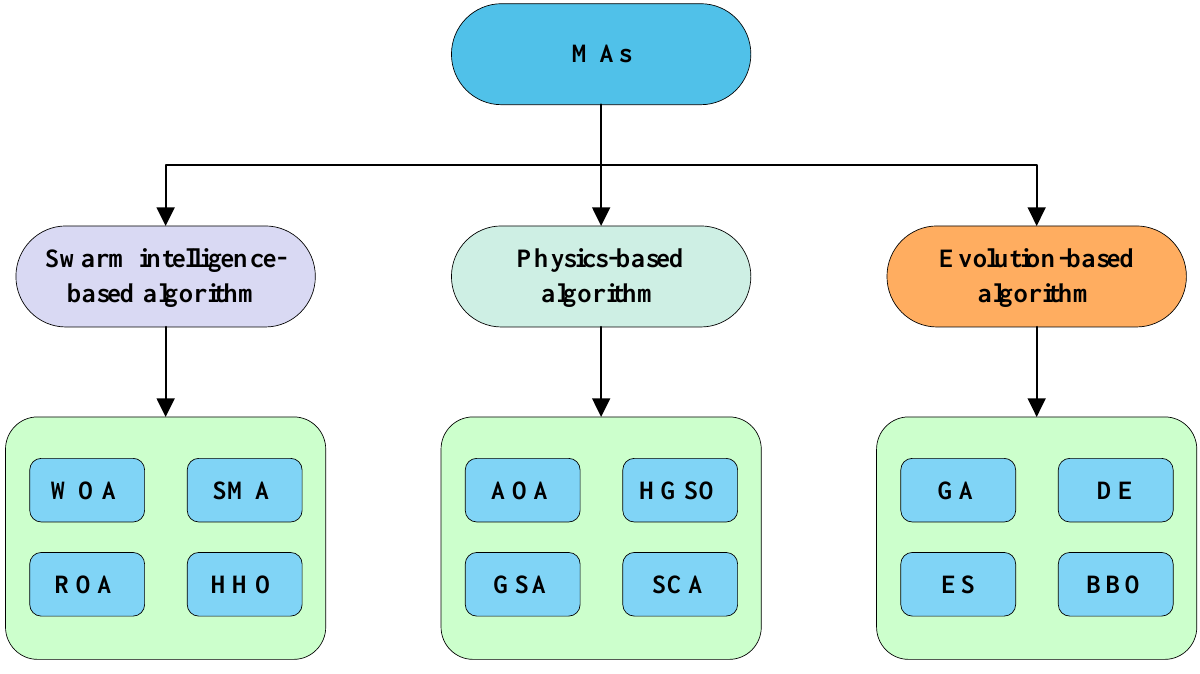
Figure 1. Classification of